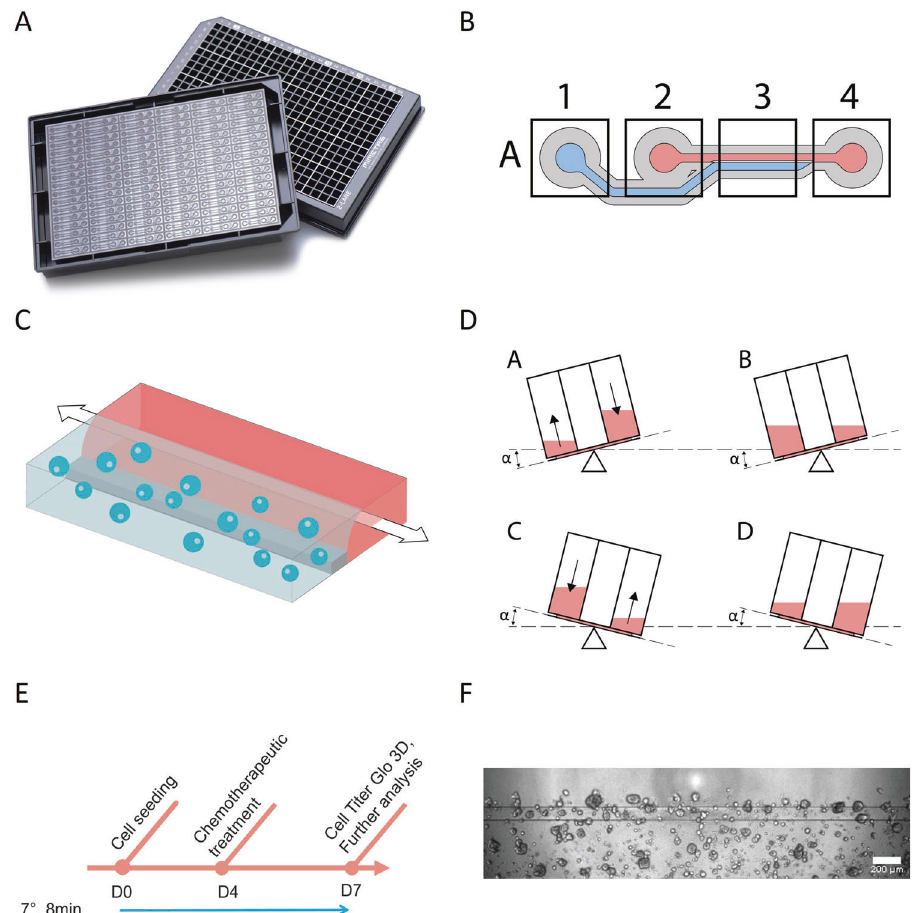
Fig. 1 Development of PDAC-on-a-Chip models. A Image of the OrganoPlate ® 2-lane from MIMETAS and ( B ) a zoomed in schematic overview of one chip. The gel inlet (A1) is connected to the gel channel (blue). The perfusion channel (red) connects the perfusion inlet (A2) with the perfusion outlet (A4). C Schematic representation of a chip fi lled with PDAC organoids and PSCs. The cells are mixed with extracellular matrix, and these are seeded in the gel channel upon pipetting into the gel inlet and subsequently distributed along the gel channel due to capillary forces. The channels are separated by Phaseguides, capillary pressure barriers, which keep the channels separate from each other and allows the strati fi ed loading of culture components. After gelation, cell culture medium was added to the medium inlet and outlet. During all experiments, when the plates were in the incubator (37 °C), these were kept on an ( D ) interval rocker at an inclination of 7° and an 8-min interval. The interval rocker ensured perfusion of the cultures. To enhance optical clarity, 50 μ l of Hanks Balanced Salt Solution (HBSS) (Sigma, 55037 C) was dispensed into the observation windows of the OrganoPlate ® 2-lane. E Timeline of the experiment: On day 0 PDAC organoids and PSCs were seeded in Matrigel suspension, cells were allowed to expand until day 4, when these were subjected to chemotherapeutic treatment for 72 h. Cell survival was analyzed using Cell Titer Glo 3D Viability assay. F Representative Phase Contrast (PC) image of a PDAC organoid monoculture in an OrganoPlate 2-Lane. 4x acquisition, Scale bar: 200 um. PC Images were acquired on the ImageXPress Micro XLS Wide fi eld High-Content Analysis System ® (Molecular Devices,